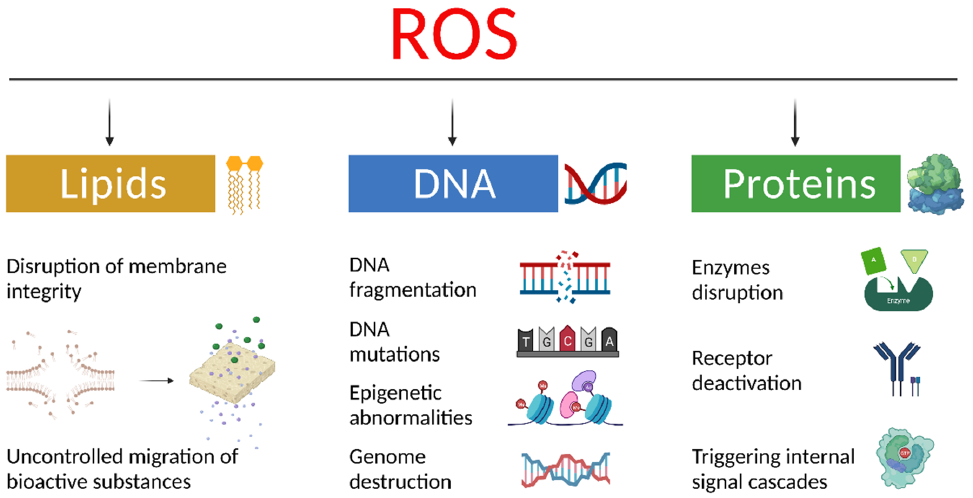
Figure 2. Consequences of the reactive oxygen species action in the cell during oxidative stress. Hyperproduction of reactive oxygen species disrupts the cell functioning by persistent oxidative damage to lipids, nucleic acids, and proteins due to the disruption of various links in the functioning of these macromolecules.